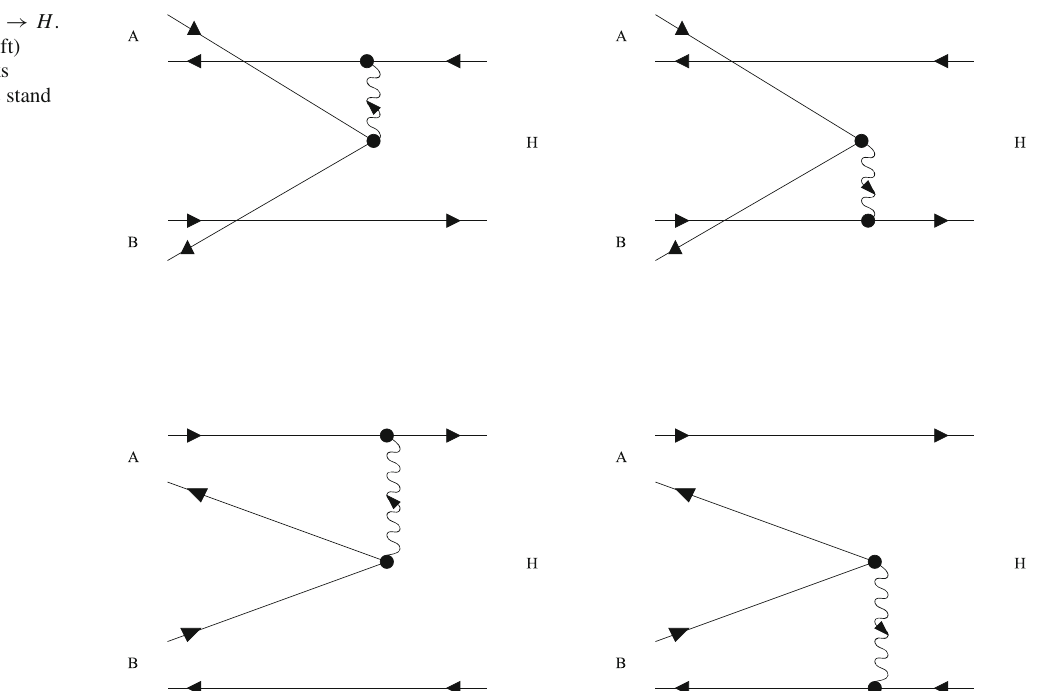
Fig. 1 Reaction A + B → H . Solid lines with right (left) triangles stand for quarks (antiquarks). Wavy lines stand for